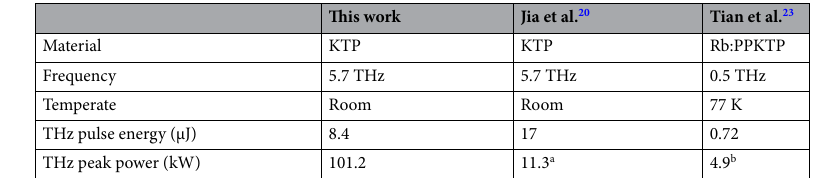
Table 1. Comparison between multi-cycle THz parametric sources using KTP. a Assuming one-fifth of the pump pulse width. b Assuming a transform limited pulse of 147 ps, although the pump pulse width is 250 ps.